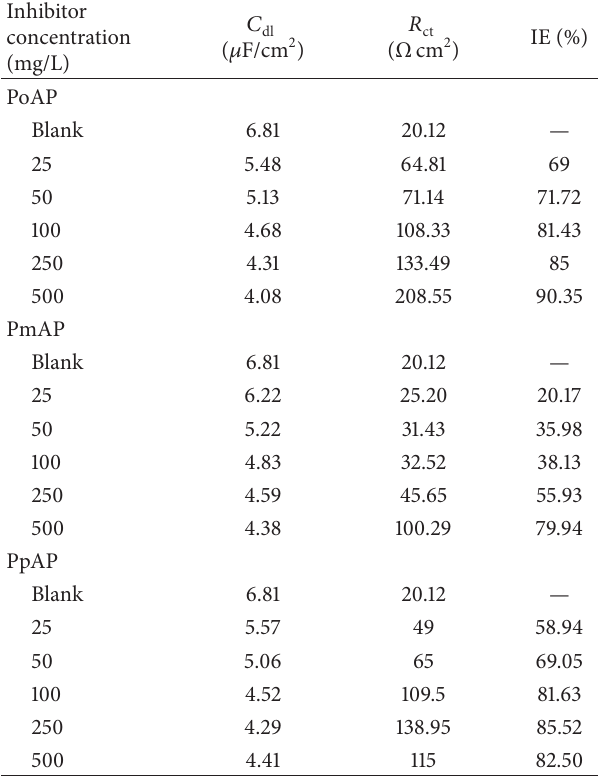
Table 3: Impedance parameters for mild steel in 1M HCl in the presence and absence of different concentrations of isomers of